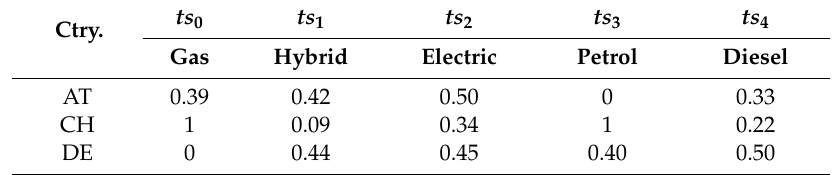
Table 4. Time shifts to relate market shares and the derivatives of the BP growth functions.